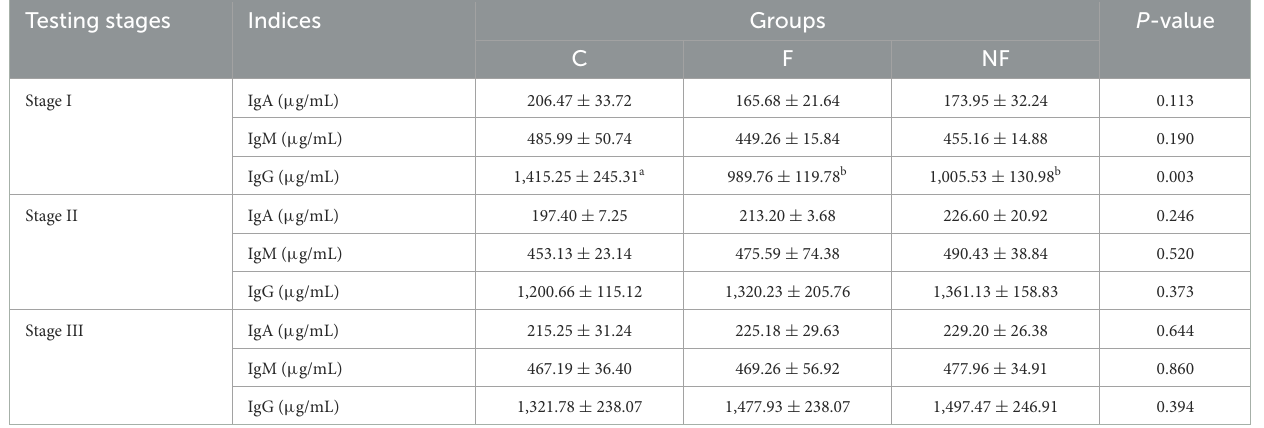
TABLE 7 Effects of non-fasting molting on immune performance of laying